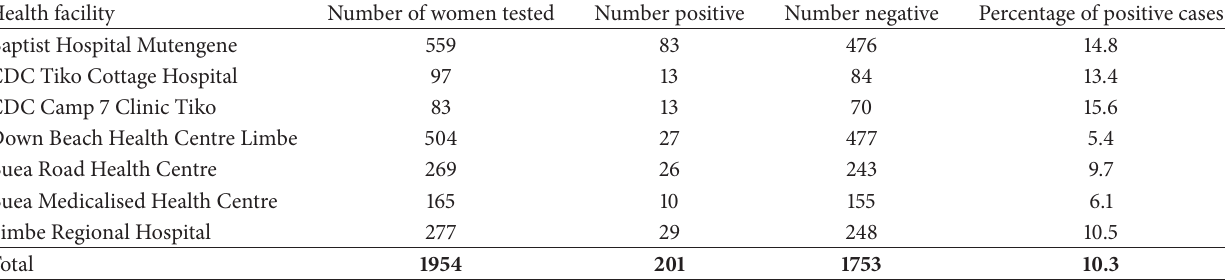
Table 1: Prevalence of HIV among pregnant women at first (booking) antenatal care visit in the various health facilities used for the study.